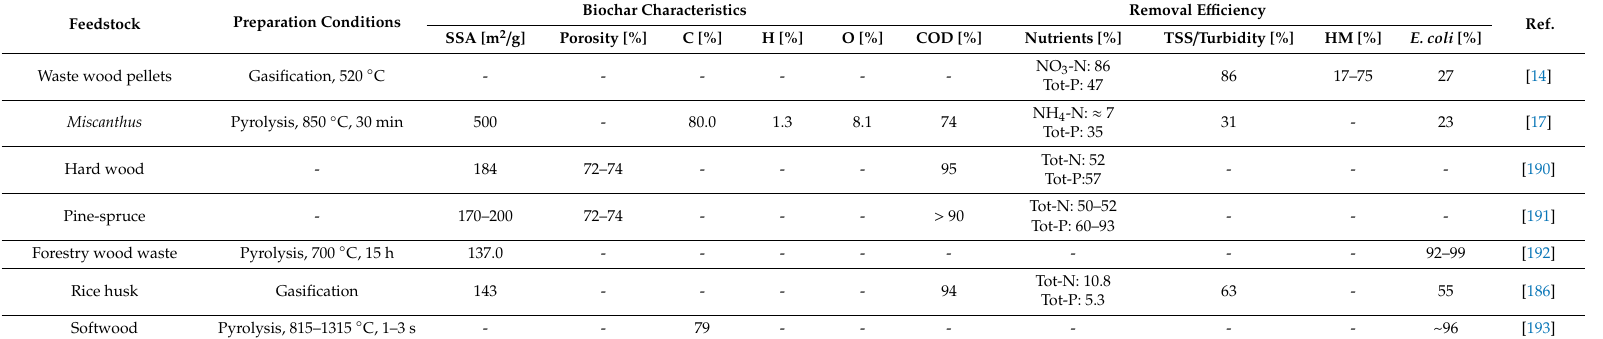
Table 4. Performance of di ff erent biochar filters used in the literature to remove pollutants from wastewater.